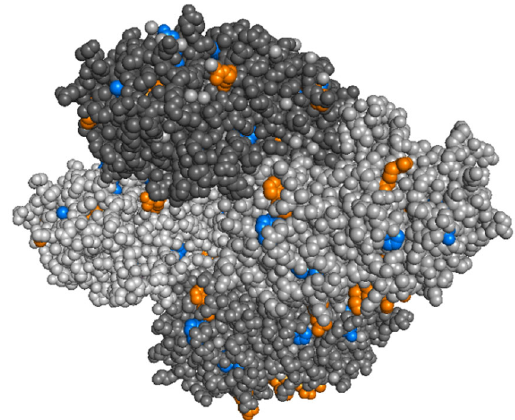
Figure 5. Labelling sites in ADH, indicated in the crystal structure (PDB accession code: 4W6Z) with the same colour code as in Figure 4.